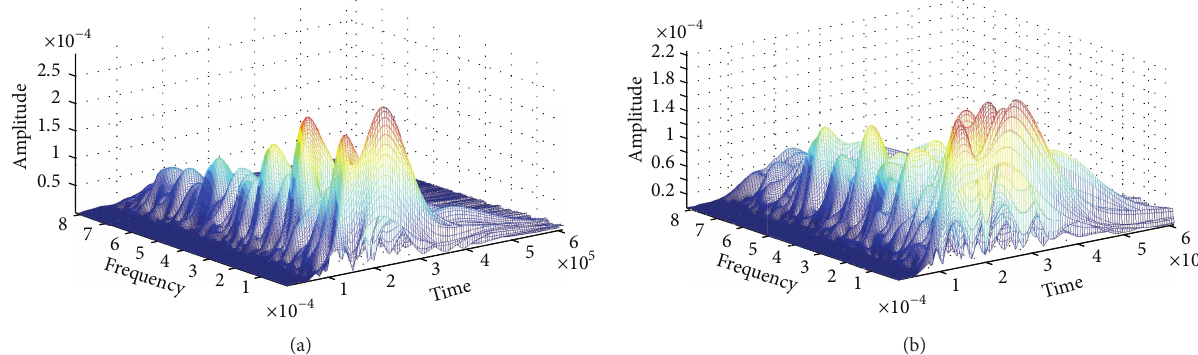
Figure 7: Fatigue crack propagation (a) base metal and (b) welded